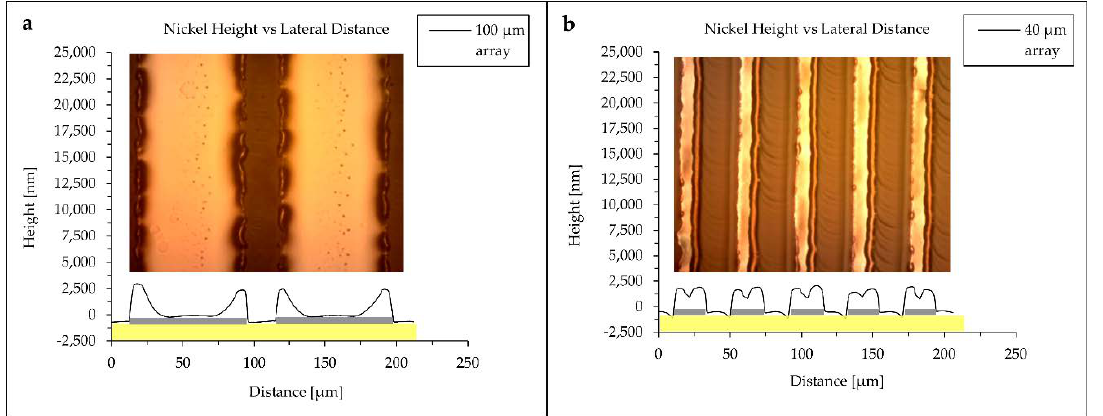
Figure 2. Optical micrographs (upper) and profilometry (lower) of Ni digits for pitch lengths of ( a ) 100 µ m and ( b ) 40 µ m. Optical micrographs have been aligned with the profiles for comparison. Yellow shading has been used to demark the polymer substrate in the profile; grey shading has been used to demark the native Ni-film layer.